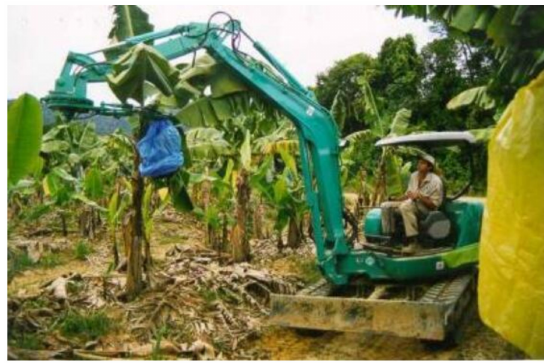
Figure 3. Crawler banana picker.